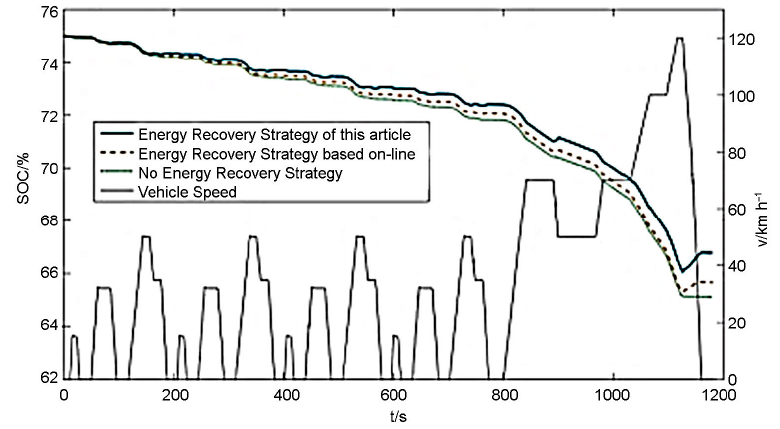
Figure 11. SOC curve with vehicle speed.